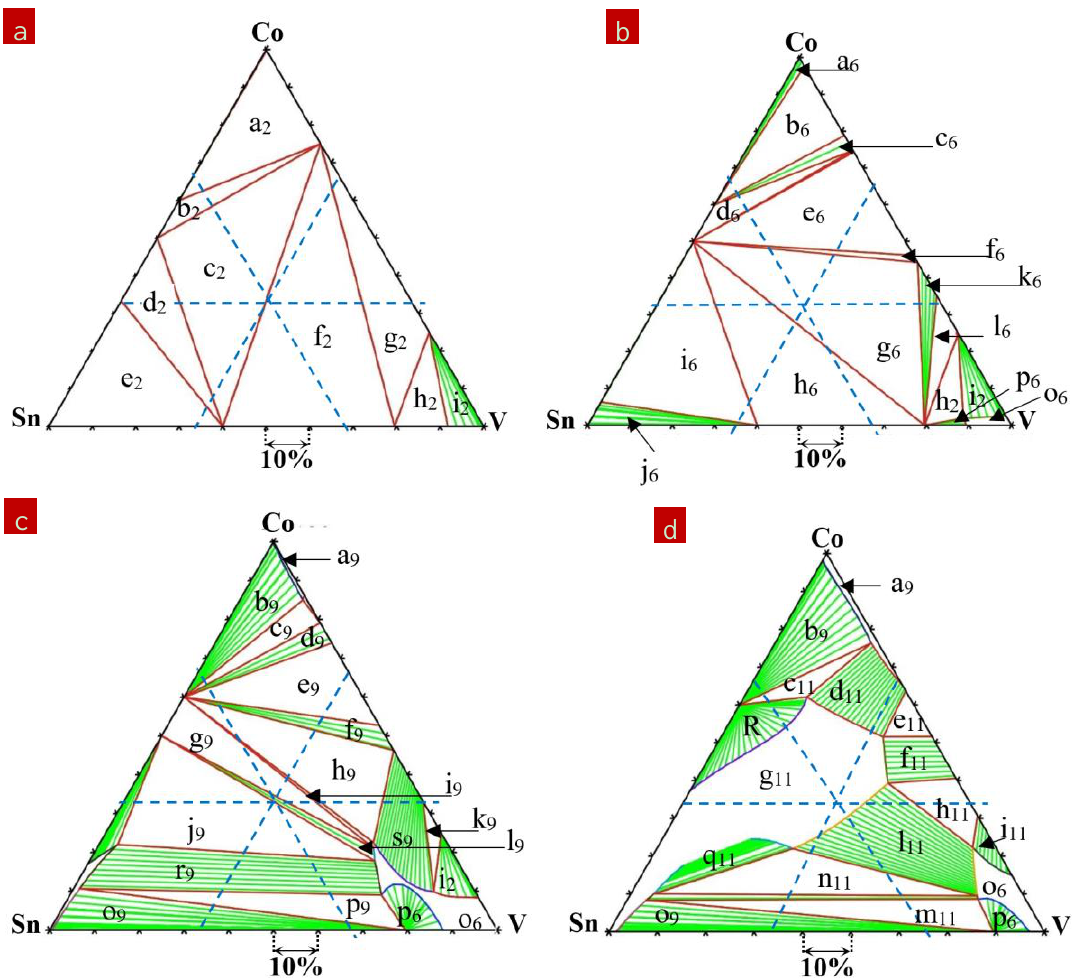
Figure 5. Temperature dependence thermoelectric parameters of CoVSn compounds. ( a ) electrical conductivity and Seebeck coefficient, ( b ) Thermal conductivity and zT.